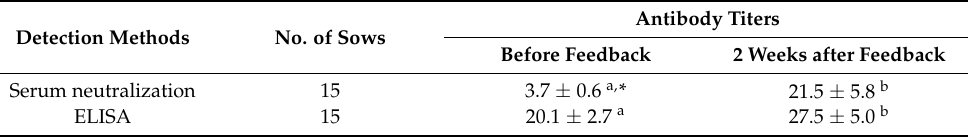
Table 3. Serum antibody titers against PEDV before and after feedback of